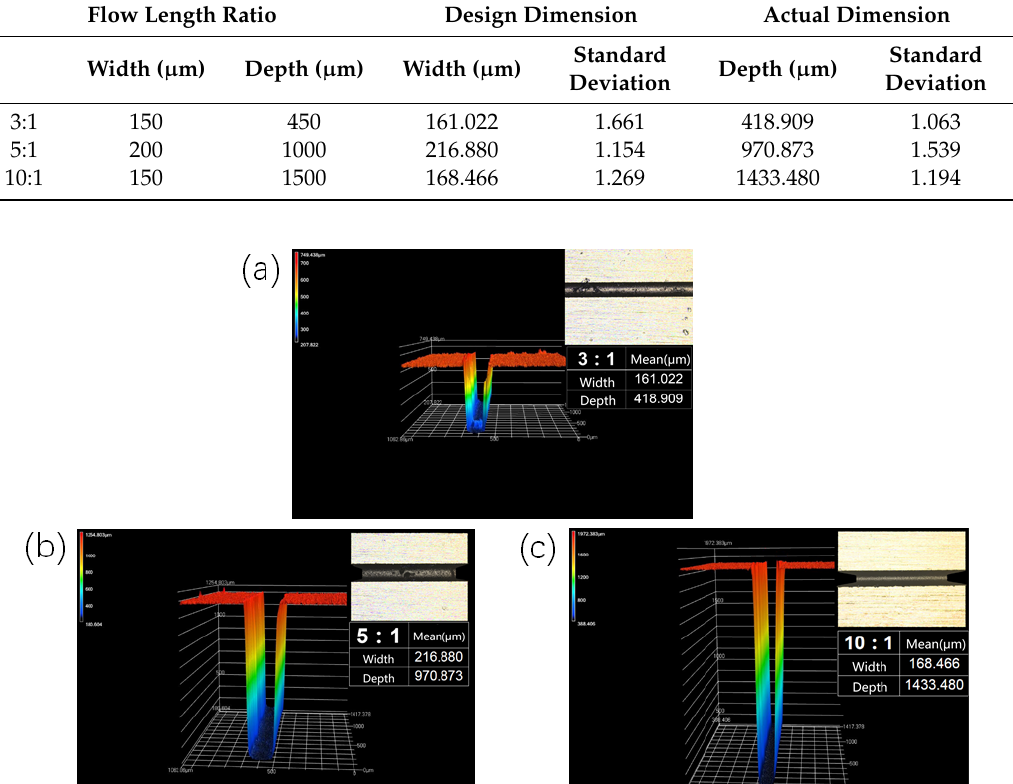
Figure 2. Actual dimensions of the mold microgrooves ( a ) flow length ratio 3:1; ( b ) flow length ratio 5:1; ( b ) flow length ratio 10:1.